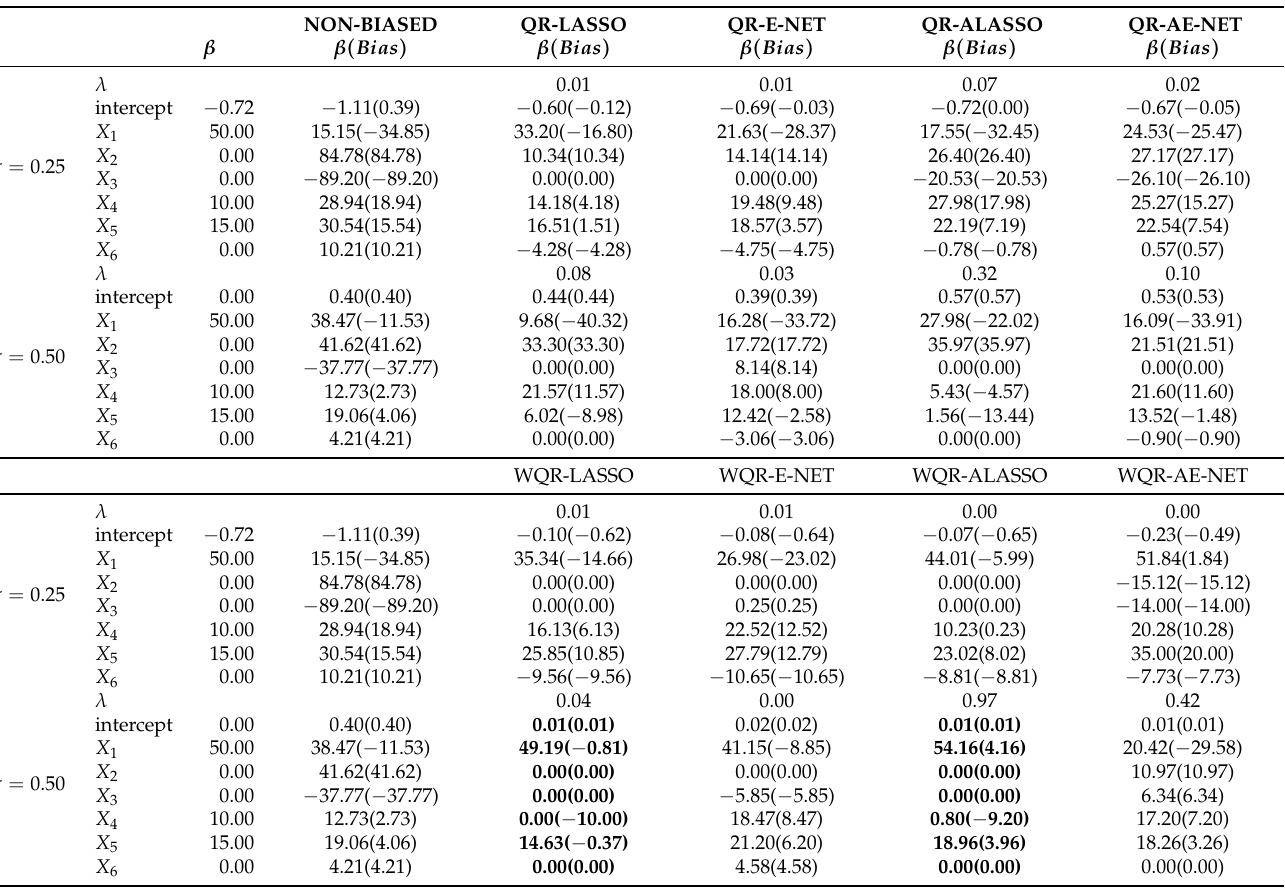
Table 7. Penalized QR parameter estimation results for the Jet-Turbine Engine data set [32]; bold text indicate superior